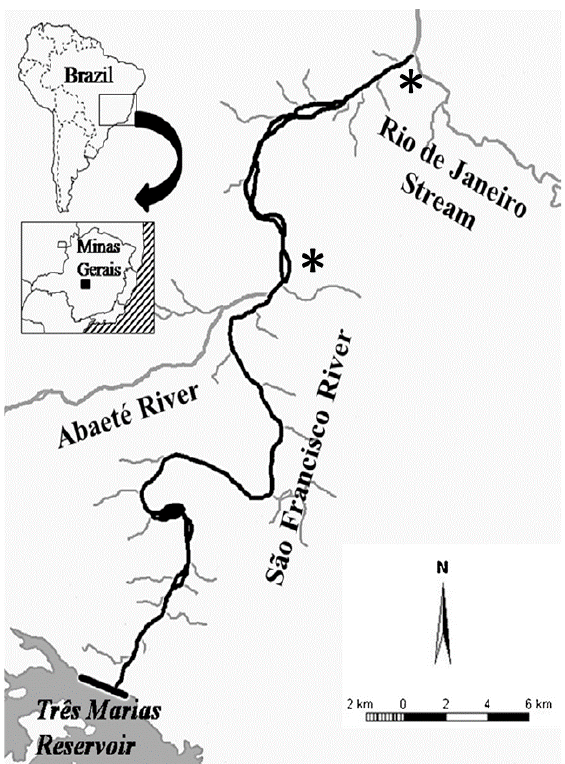
Figure 1. Study area: São Francisco River (SFR) 34 (*) to 54 km (*) downstream of the Três Marias dam after the confluence of the SFR with the Abaeté